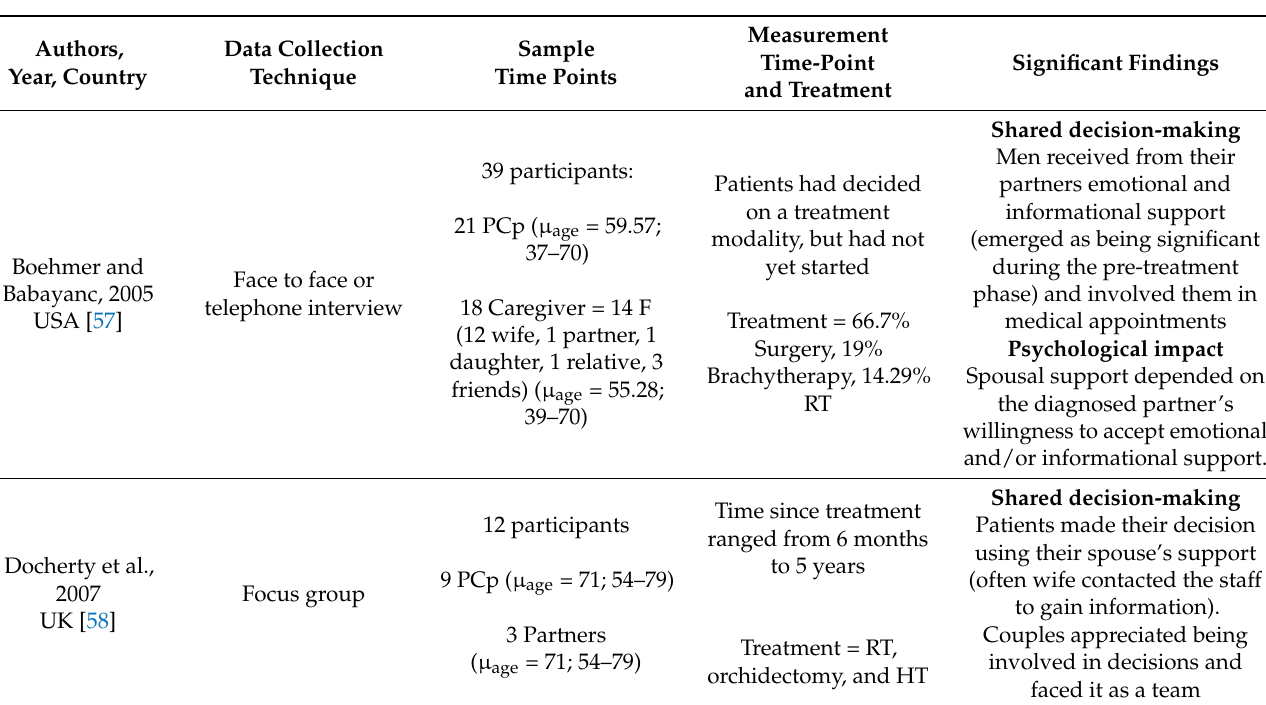
Table 3. Qualitative